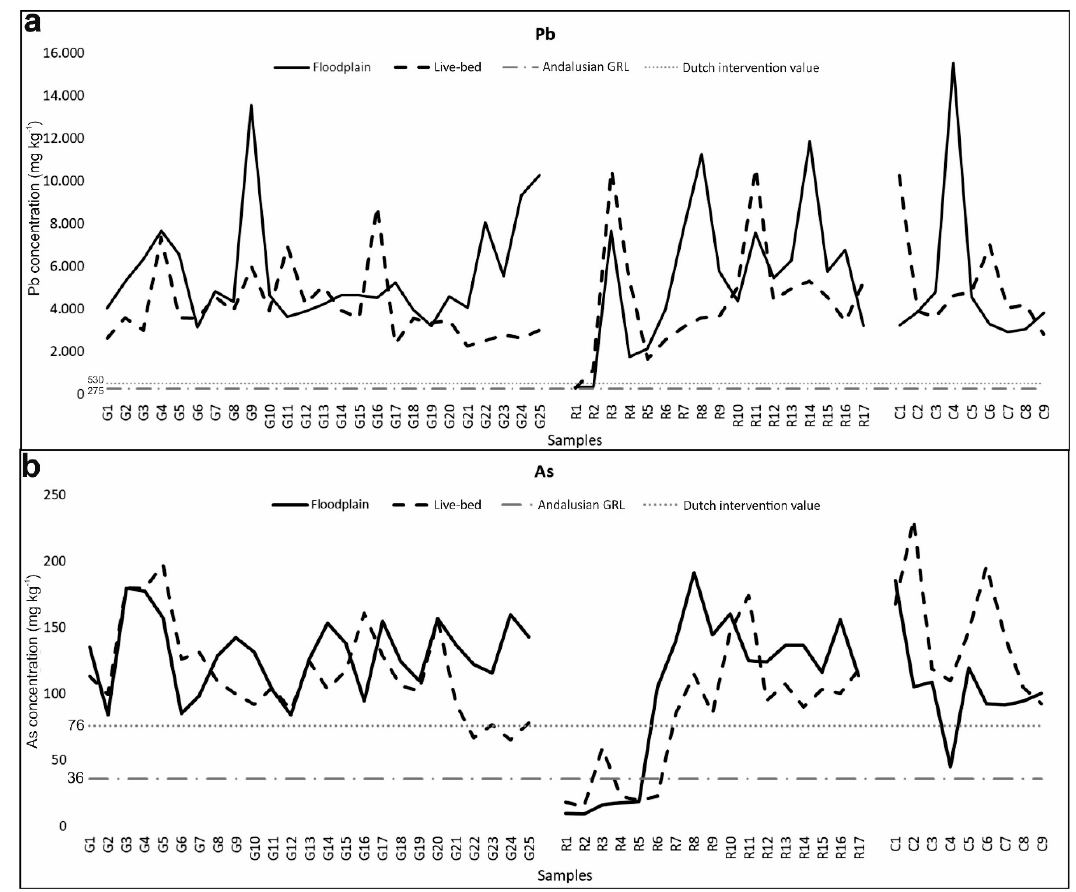
Figure 3. Distribution of Pb and As contents in sediments from La Carolina mining district. ( a )—Pb; ( b )—As. Generic reference levels (GRL) established by the regional government of 275 mg/kg for Pb and 36 mg/kg for As (Junta de Andalucía 2015) and Dutch intervention values of 530 mg/kg for Pb and 76 mg/kg for As (Dutch Ministry 2013) are showed.